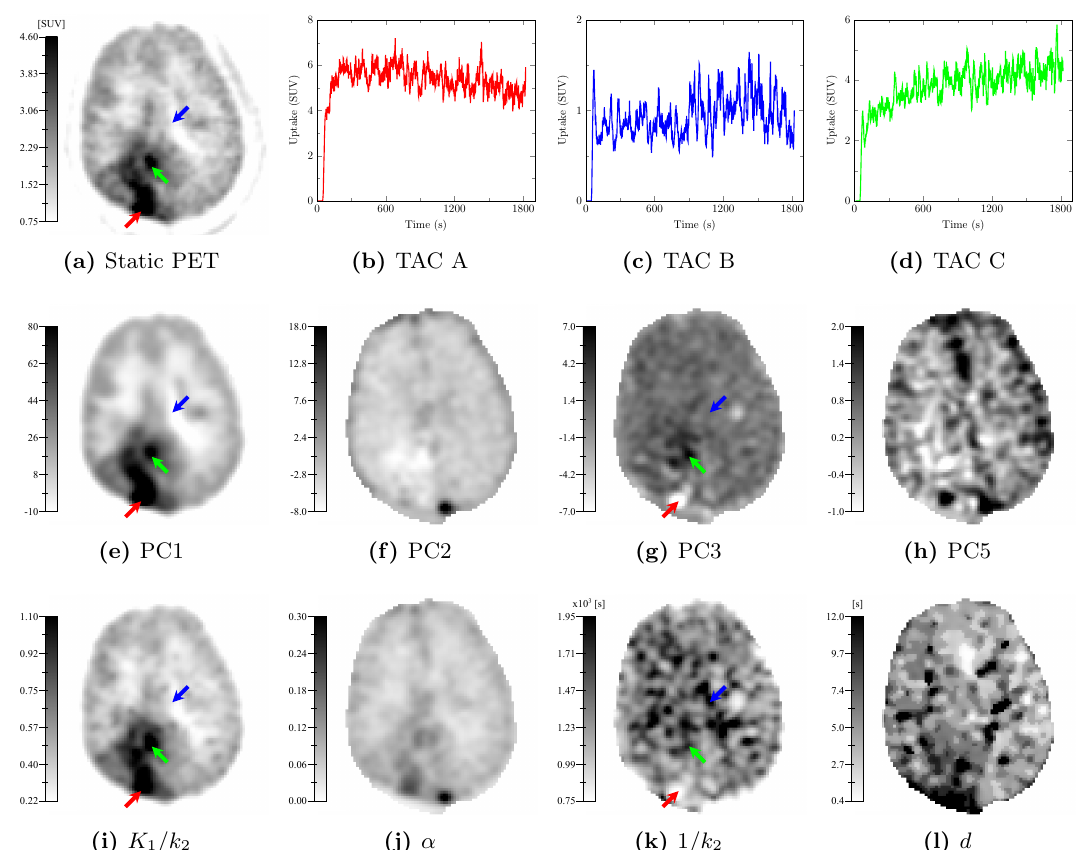
Figure 7. Parametric maps generated from the dynamic [ 11 C]MET PET scan of a glioblastoma evaluation patient (patient 21 in Table A1). ( a ): Static PET image (20–27 min p.i.). ( b – d ): Smoothed TACs at voxels pointed by the red, blue, and green arrows, respectively. TAC A, B, and C, respectively, have a ‘decreasing’, ‘flat’, and ‘increasing’ behavior. ( e – h ): Mapped values of the principal components 1–3 and 5 determined on the real model-building dataset. ( i – l ): 1TCM kinetic parameter maps. All maps are displayed in inverted